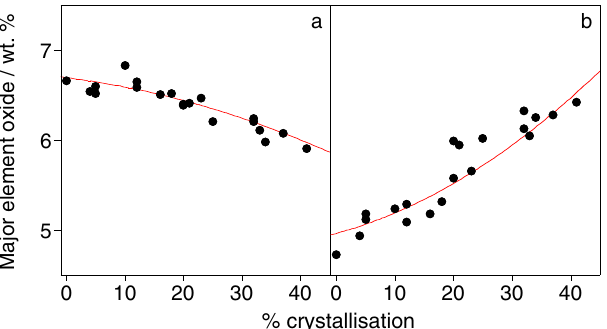
Fig. 4 Major element contents of the basanite-nephelinite suite. Measured (black) and predicted (for a fractionating assemblage of clinopyroxene (63%), garnet (32%), and phlogopite (5%); red) a MgO and b Na 2 O contents of the glasses versus the degree of crystallisation determined from fi tting the trace element contents to the equation for fractional crystallisation (Eq.